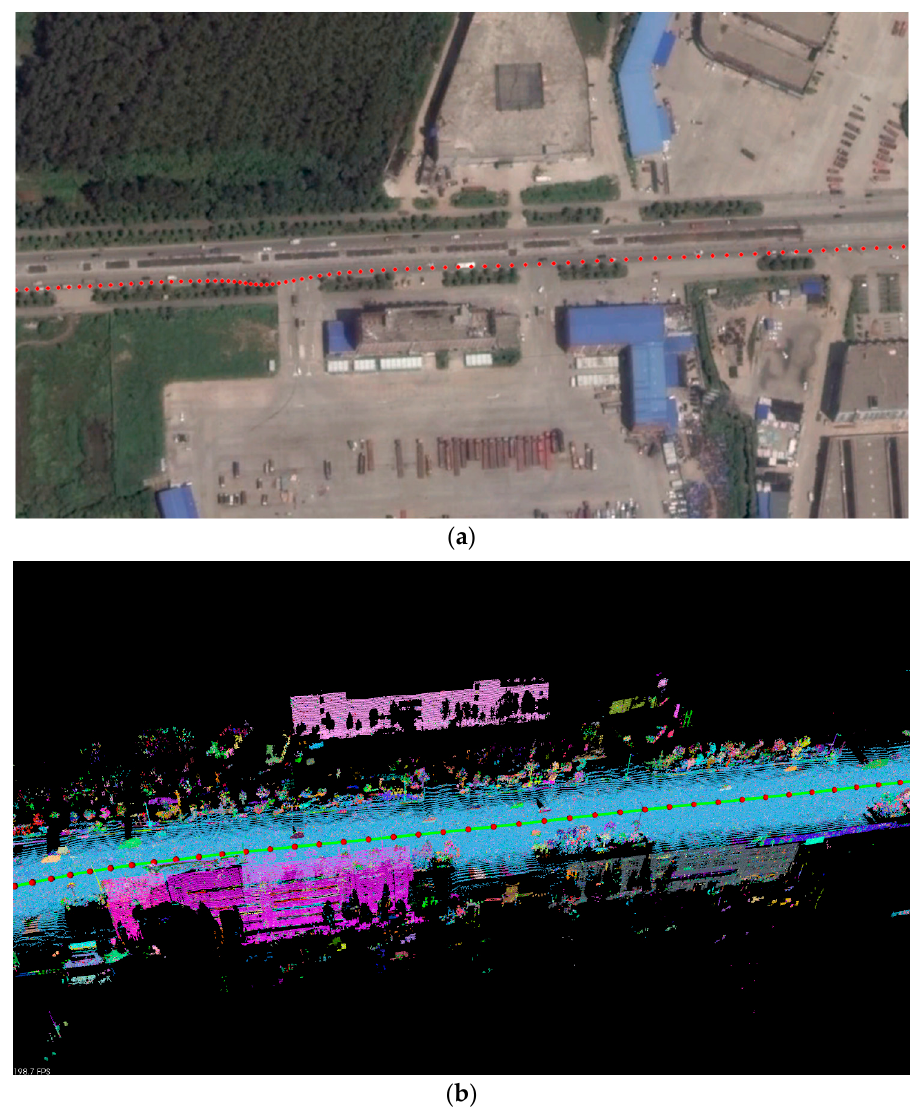
Figure 10. Overview of the test data: ( a ) the test area in Google Earth; ( b ) 3D point cloud of the test